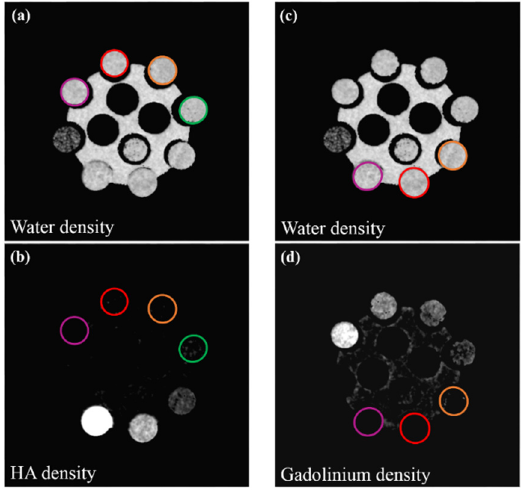
Figure 4. Selection of ROIs over control solutions in target materials HA density ( b ) and gadolinium density images ( d ); and their comparison with the corresponding voxels in the water density images ( a , c ). The percentage of successful voxels over each concentration which is correctly identified as not the target material in the control ROI provides the true negative rate whereas unsuccessful voxels provide the false positive rate.